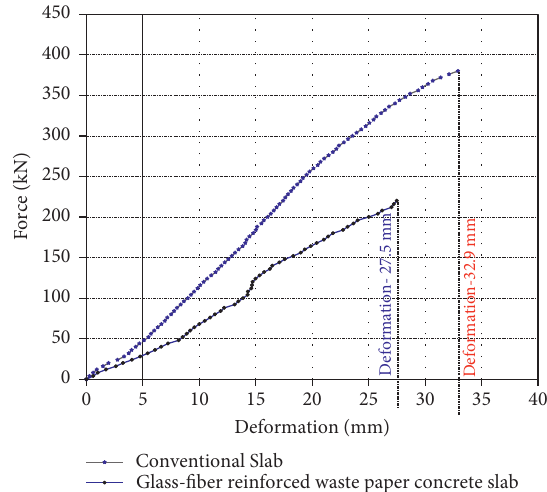
Figure 11: Force-deformation characteristics of the slab.